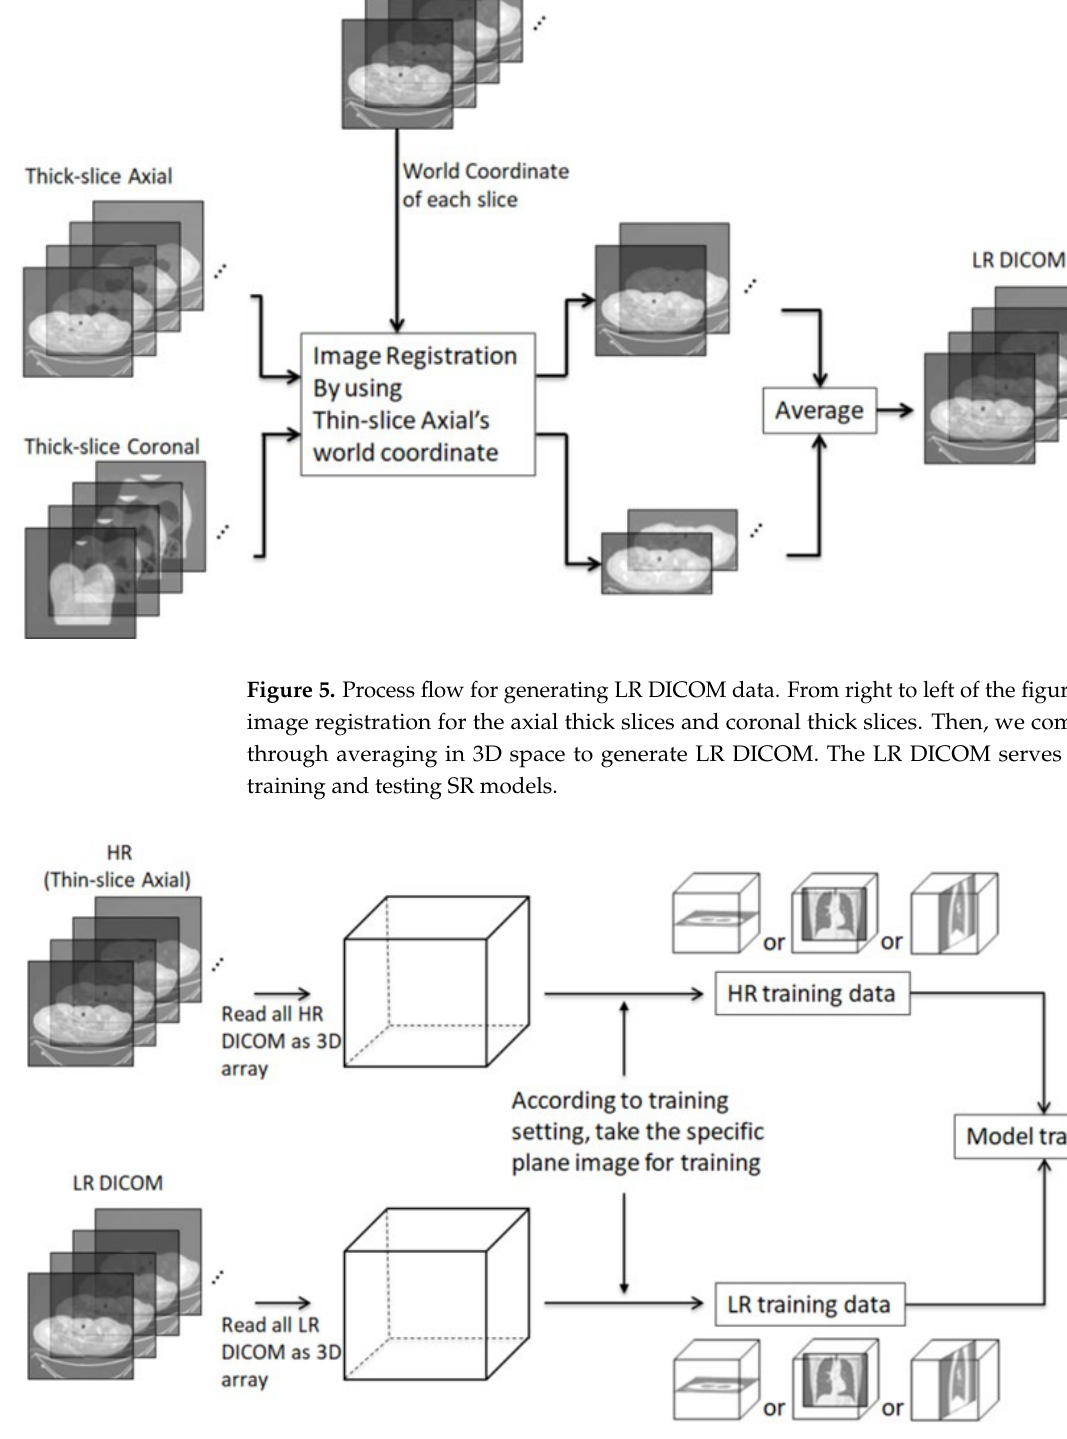
Figure 6. Diagram of model training for a specific plane.